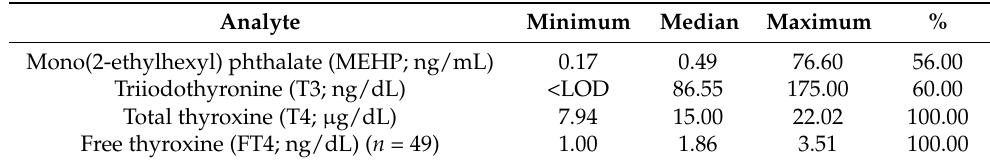
Table 1. Descriptive statistics of mono(2-ethylhexyl) phthalate (MEHP) and thyroid hormone con- centrations for individual dolphins ( n = 50 unless otherwise specified) sampled from Sarasota Bay, Florida (2010–2019). Frequency of detection is given as